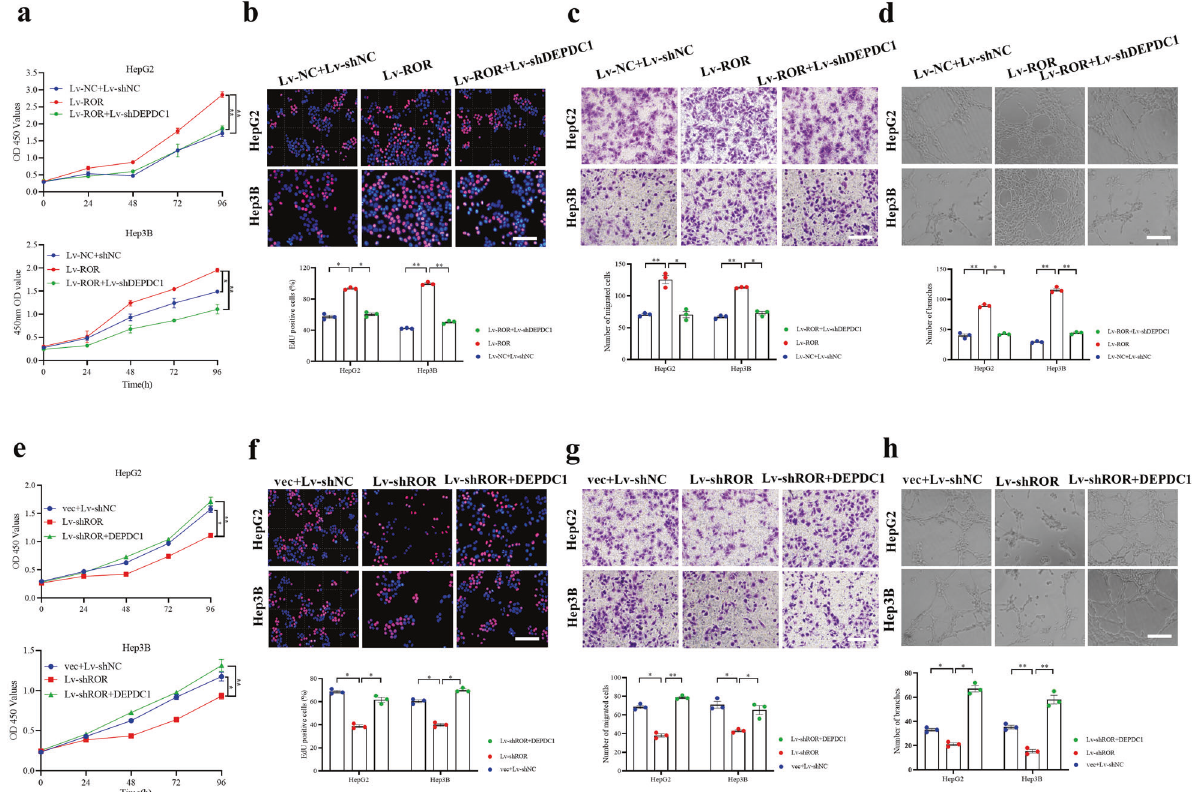
Fig. 6 Linc-ROR increased the progression and angiogenesis via DEPDC1 in HCC cells. a Cell proliferation was assessed daily for 4 days using the Cell Counting Kit-8 (CCK-8) assay in Linc-ROR overexpressing HepG2 and Hep3B cells. b EdU assays were performed to analyze the HepG2 and Hep3B cell proliferation in differently transfected groups. c Transwell assays were used to evaluate the involvement of Linc-ROR for invasion in Linc-ROR overexpressing HepG2 and Hep3B cells. d Effect of Linc-ROR expression in HepG2 and Hep3B cells on human umbilical vein endothelial cells (HUVECs) in tube formation assay. Each bar represents the mean values ± SD of three independent experiments. e , f Cell proliferation assessed in Linc-ROR knockdown HepG2 and Hep3B cells. g Transwell assays assessed in Linc-ROR knockdown HepG2 and Hep3B cells. h Tube formation assay assessed in Linc-ROR knockdown HepG2 and Hep3B cells. Data are shown as mean ± SD, n = 3. The data statistical signi fi cance is assessed by Student ’ s t test. * P < 0.05, ** P < 0.01, *** P < 0.001. Scale bars: 50 μ